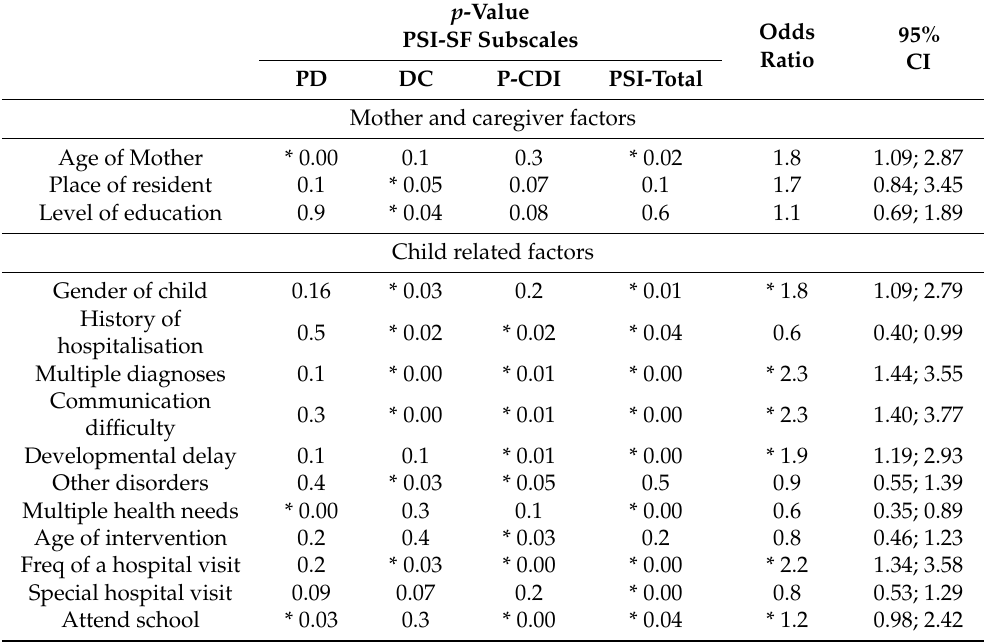
Table 4. Association between parental stress and the three subscales of the parental stress